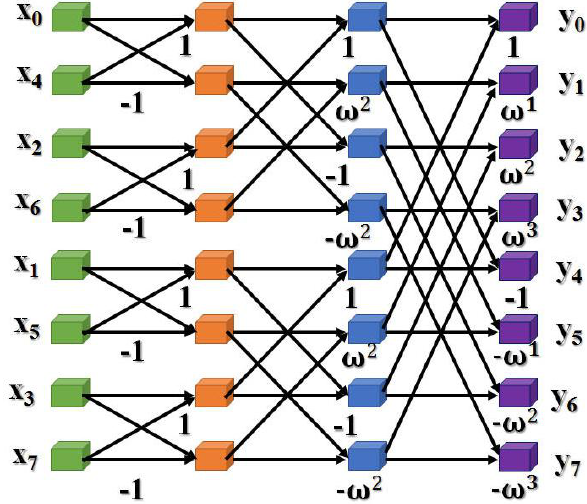
Figure A4. The FFT algorithm processes (when n =